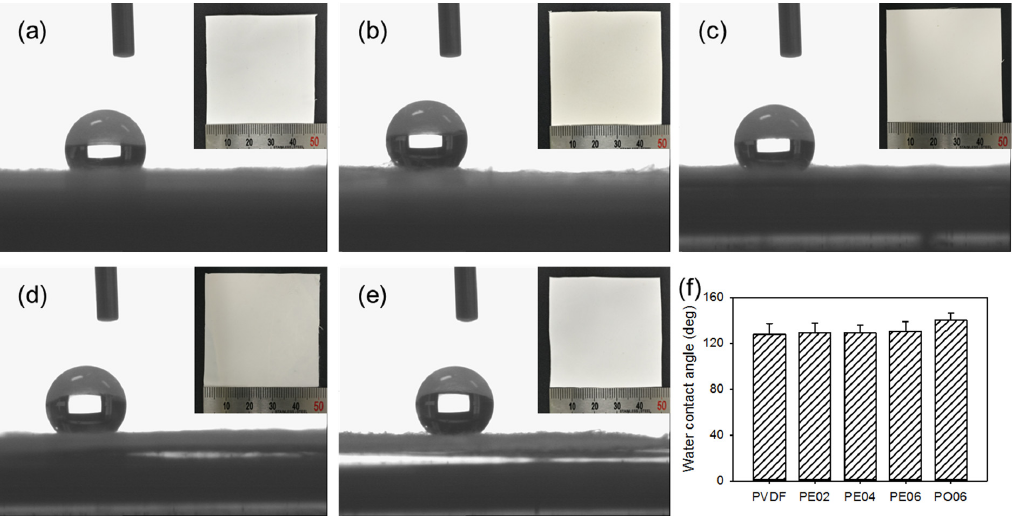
Figure 6. Contact angle images for water droplet on ( a ) PVDF, ( b ) PE02, ( c ) PE04, ( d ) PE06, and ( e ) PO06 composite nanofibers. ( f ) Average contact angles on PVDF composite nanofibers determined by contact angle meter ( n = 5). Insets are photographs of PVDF composite nanofibers. Table 1. Mechanical properties of the PVDF composite nanofibers with different contents of the POSS–EGCG